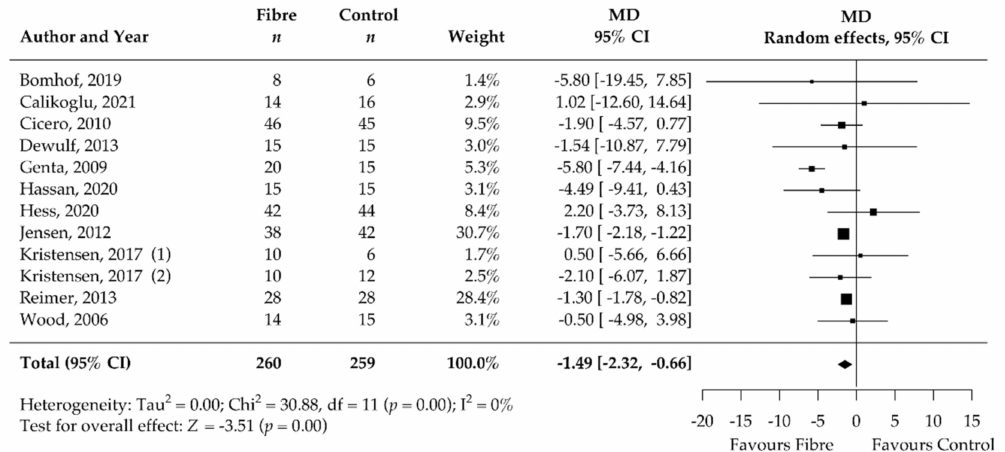
Figure 6. Isolated soluble dietary fibre supplementation significantly decreased fasting blood insulin [mIU/L] in overweight and obese people ( n = 519). Black rectangles represent MD for each study; the size of the rectangle is proportional to the weight of the study for the pooled effect. Horizontal lines indicate 95% CI. The black diamond summarises the pooled MD data. MD = mean difference;